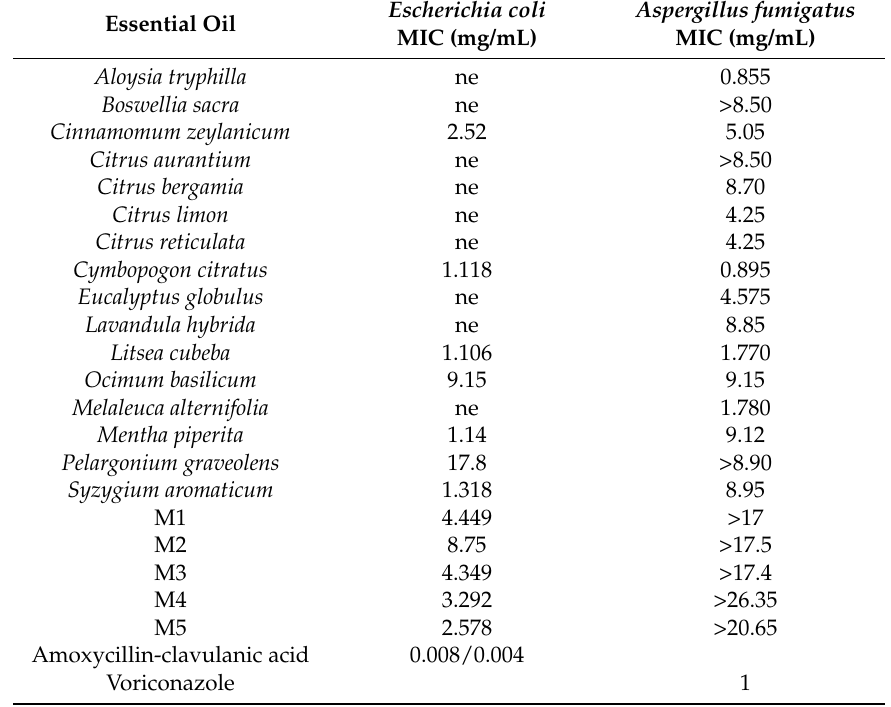
Table 3. Antimicrobial activity expressed as growth inhibition zone and minimum inhibitory concentration of the sixteen EOs and five mixtures against Escherichia coli and Aspergillus fumigatus strains. Essential